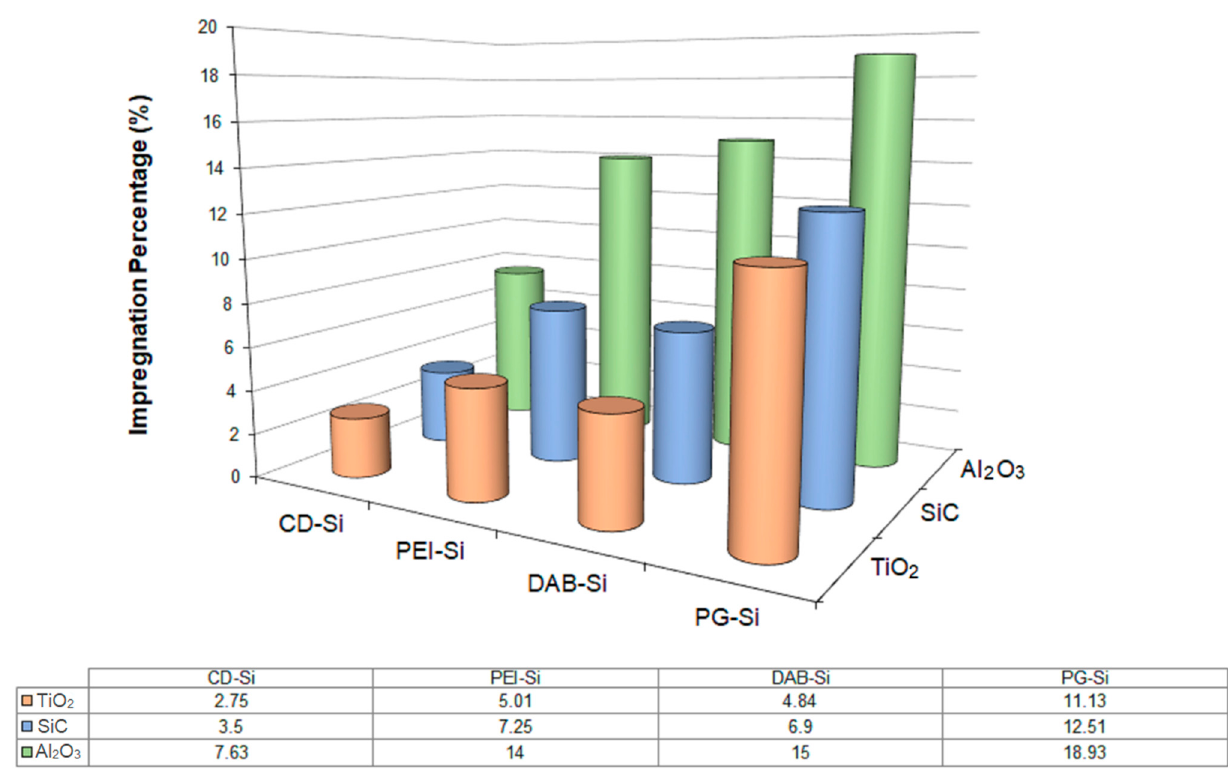
Figure 5. Loading percentage for three ceramic filters of different origins (TiO 2 , SiC, Al 2 O 3 ) after their immersion into 30% solutions of triethoxy silated dendritic and cyclodextrin polymers (Reproduced with permission from [59]; Copyright Elsevier, 2006).